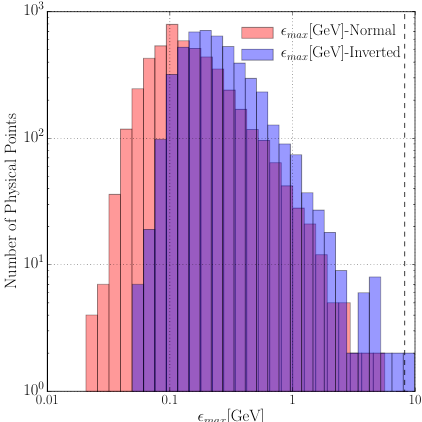
Figure 5. For each of the 4,858 black points with a Wino chargino LSP, we statistically sample one of the three (cid:15) i parmeters in the range [10 (cid:0) 4 ; 1 : 0] GeV and, for this graph, choose 1) a normal neutrino hierarchy and sin (cid:18) 23 = 0 : 597 | indicated in red | and 2) an inverted hierarchy with sin (cid:18) 23 = 0 : 529 | indicated in blue. We then solve for the other two (cid:15) values numerically. For each case, we plot a histogram of the number of valid black points associated with a Wino chargino LSP against the value of (cid:15) max , the largest of the three epsilon parameters. We (cid:12)nd that most values of (cid:15) max are smaller than 1 GeV. For larger values, the viable points become much less numerous, since such values would require more (cid:12)ne-tuning to match the existent neutrino data. The bound p 68 GeV | see the end of section 3 | beyond which unphysical lepton number violation is possible, is indicated by the dashed line. We (cid:12)nd only 1 and 4 points beyond this line for the normal and inverted hierarchy cases respectively. Hence, lepton number violation, if it occurs at all, is statistically insigni(cid:12)cant in our